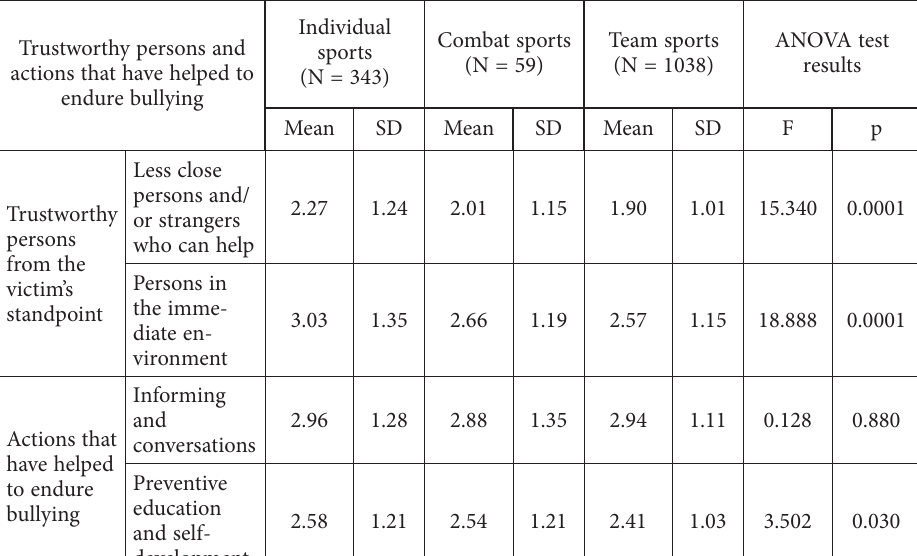
Trustworthy persons and actions that have helped